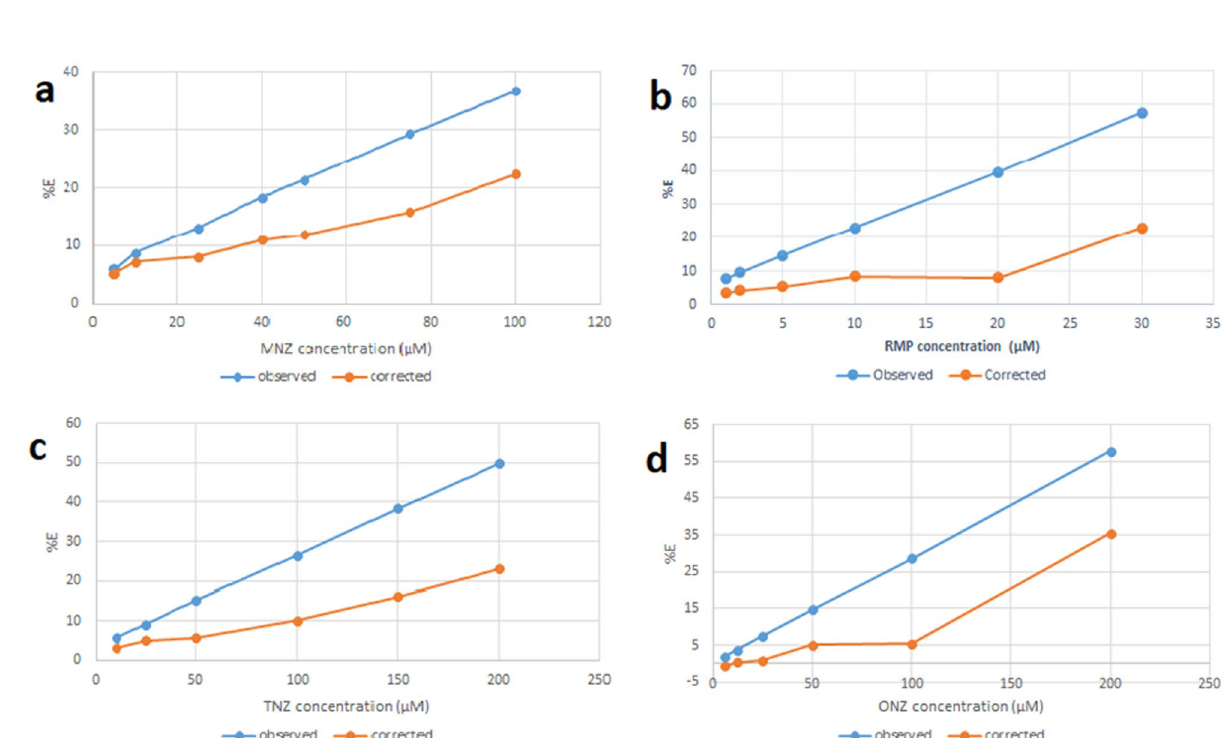
Figure 7. Suppressed efficiency (%E) of observed and corrected fluorescence of SN-CQDs after addition of different concentrations of MNZ ( a ), RFP ( b ), TNZ ( c ), and ONZ ( d